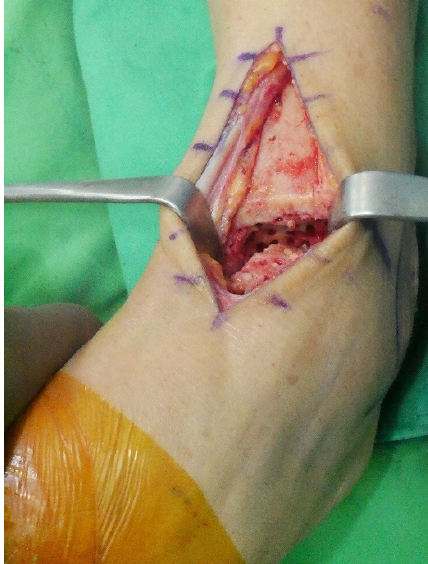
Figure 5. After dissection was performed between the tibialis anterior and extensor halluces longus tendons to expose the joint, cartilage and subchondral bone of the medial gutter were removed.